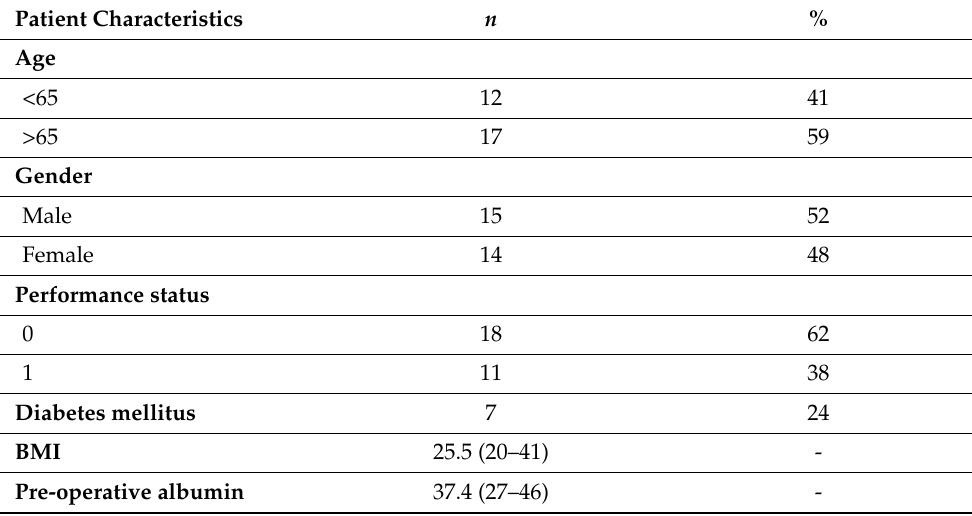
Table 2. Characteristics of patients receiving